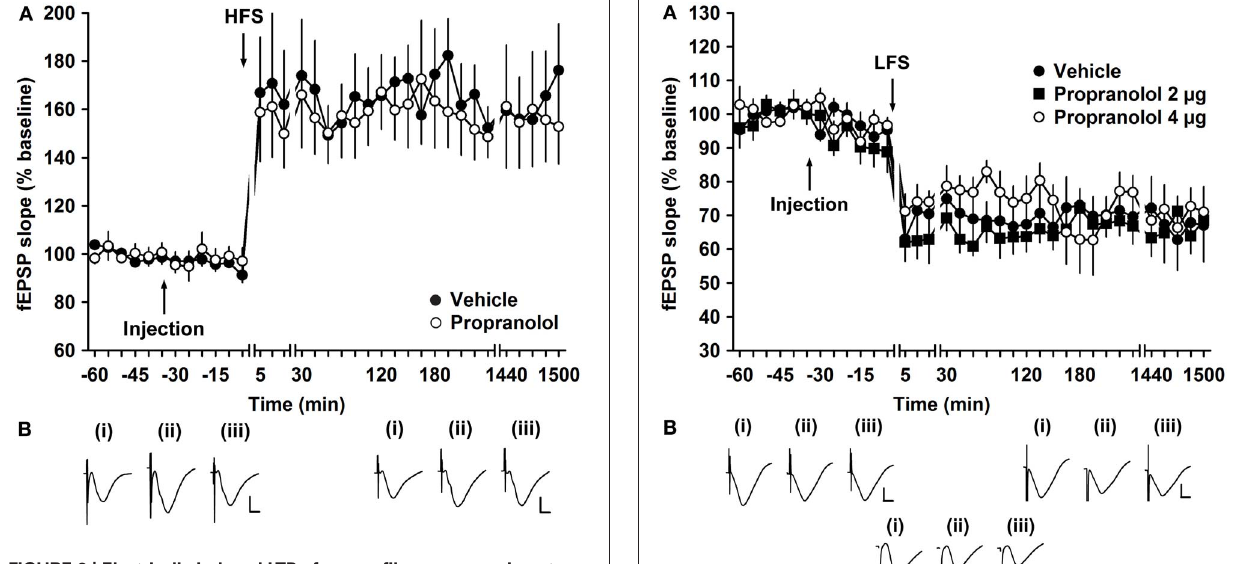
FIGURE 3 | Electrically induced LTP of mossy fiber synapses is not affected by application of a β -adrenergic receptor antagonist. (A) HFS (four trains of 100 pulses given at 100Hz) elicits LTP. Injection of the β -adrenergic receptor antagonist, propranolol (2 μ g), did not change the profile of the LTP elicited. Line breaks indicate changes in time scale. (B) Analog traces represent recordings taken (i) 5min pre-LFS, (ii) 5min post-HFS, and (iii) 24h in the presence of vehicle ( left panel ), or propranolol ( right panel ). Vertical scale bar: 2mV, horizontal scale bar: 6ms.